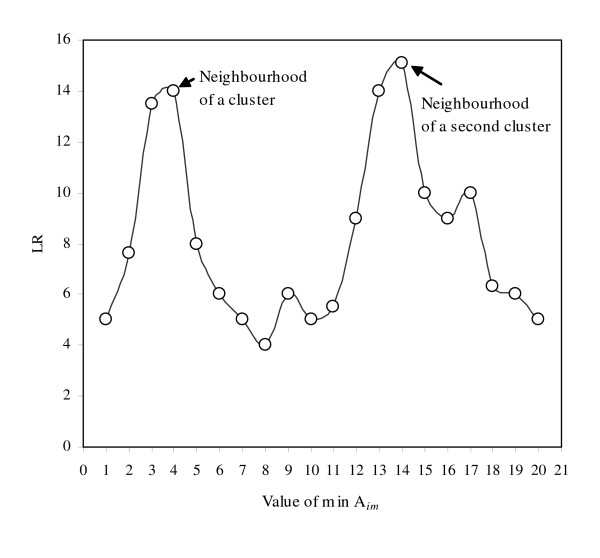
Illustration of how a search proceeds within a spatial neighbourhood.